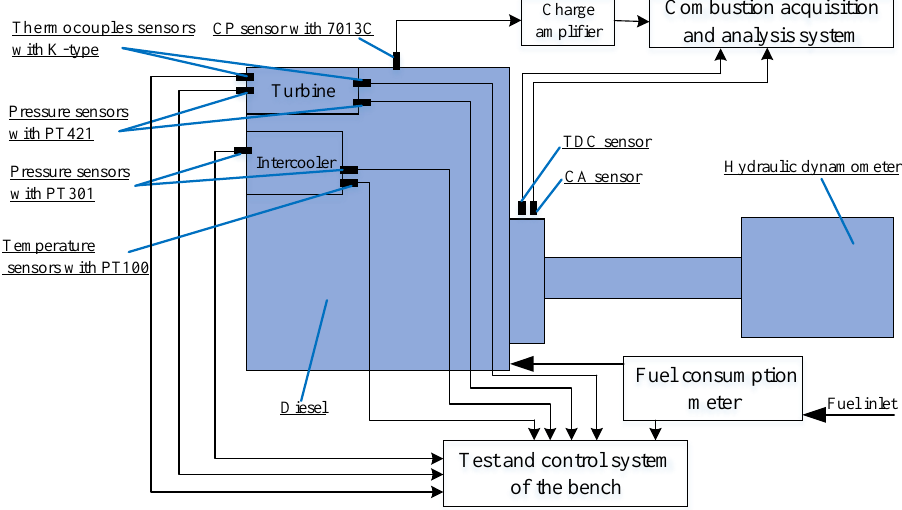
Figure 2. The routine test bench and measurement system of the diesel engine.